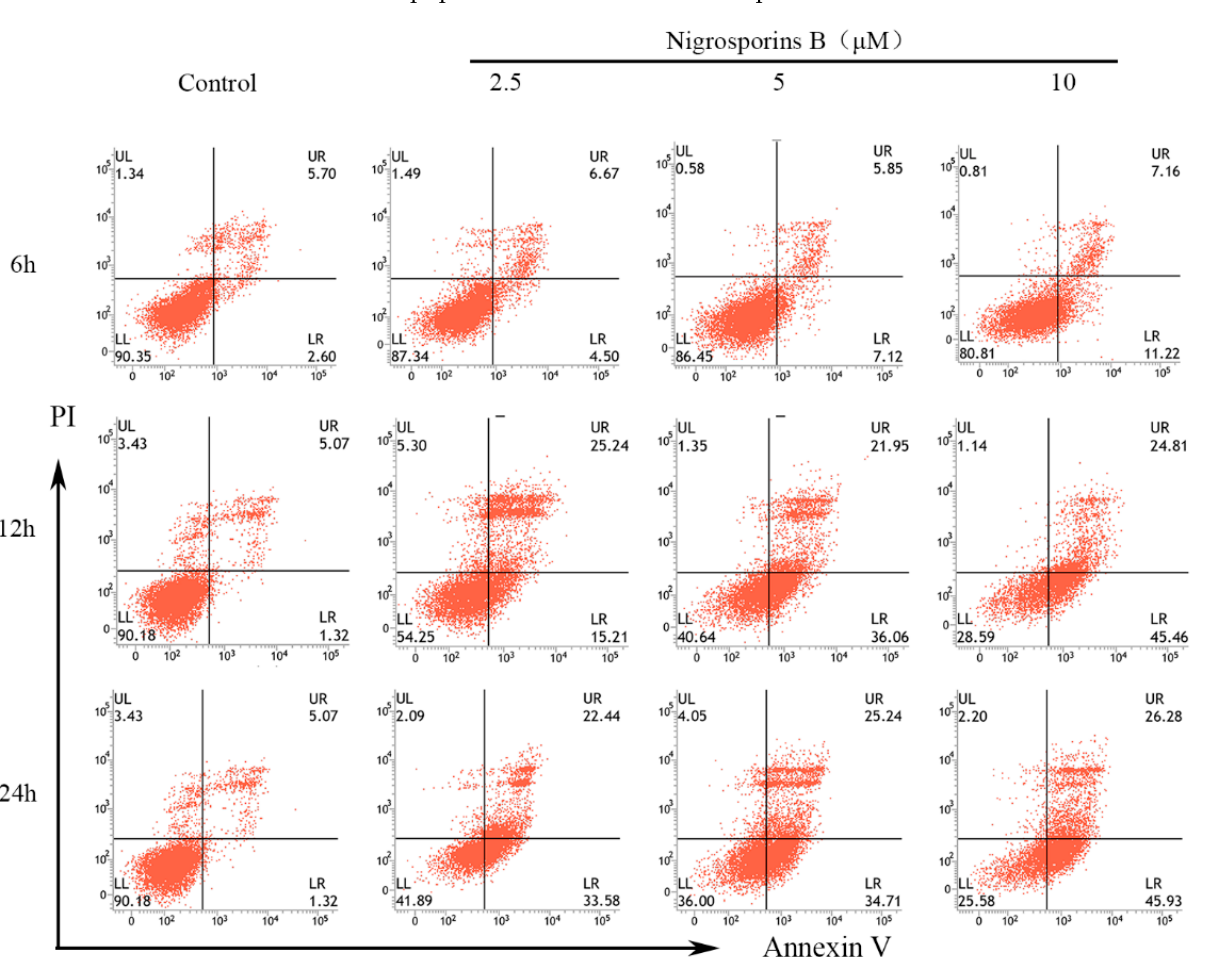
Figure 3. Nigrosporins B induced apoptosis in Ca Ski cells. ( A ) The total apoptotic cells proportion treated with Nigrosporins B (0, 2.5, 5, 10 µM) for 6 h, 12 h, 24 h were counted respectively; ( B ) and ( C ) AO/EB dual fluorescence staining to detect apoptosis in Ca Ski cells, cells treated with Ni- grosporins B (0, 2.5, 5, 10 µM) for 24 h. Scale bar: 100 µM. Normal cells, showed green showed green fluorescence; early-stage apoptotic cells showed yellow-green fluorescence; late-stage apoptotic cells showed orange fluorescence; necrotic cells showed red fluorescence (* p < 0.05, *** p < 0.001).